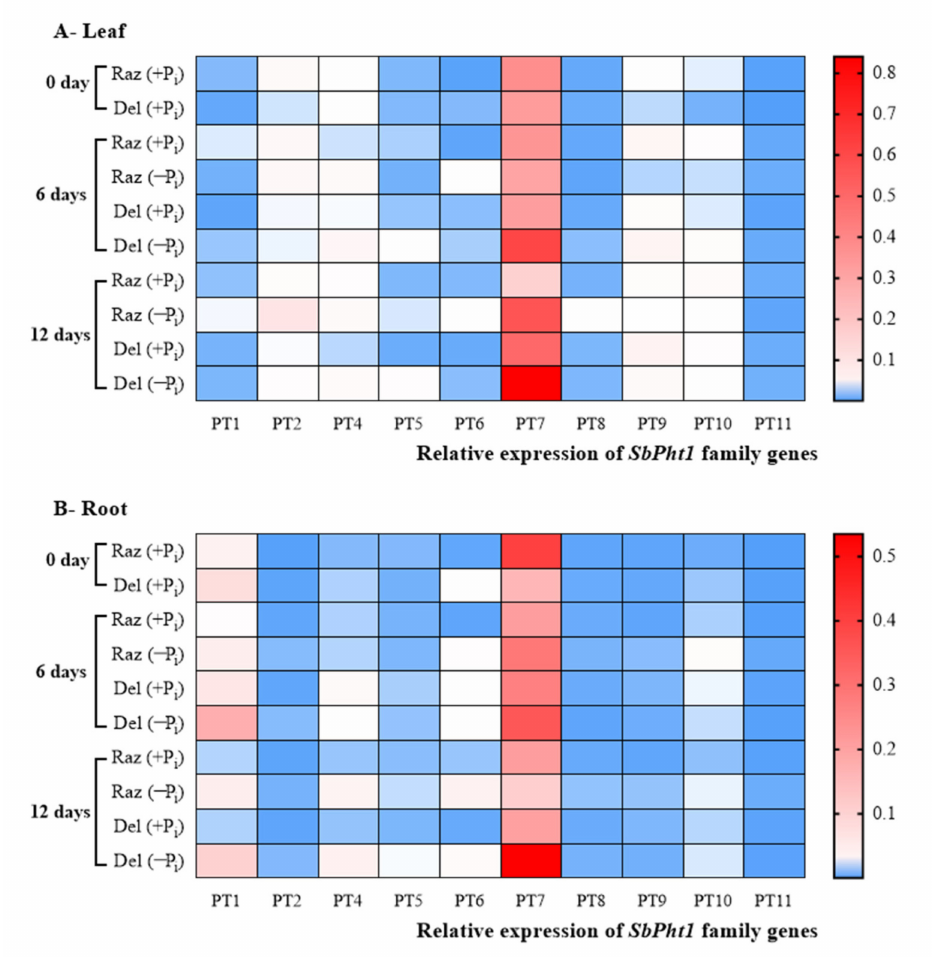
Figure 4. Expression profiles of 10 sorghum SbPht1 genes in leaves and roots of a grain (Razinieh) and a sweet (Della) sorghum variety grown under P i starvation treatments. ( A , B ) Relative expression of SbPht1 family genes in the leaf and the root, respectively. The seeds of two varieties were initially grown in agar with 8% MS for 10 days; after that, the seedlings were transferred to half Hoagland solution for 2 days, followed by full Hoagland solution for 4 days to obtain greater adaptation. Thereafter, the seedlings were subjected to 2 mM NH 4 H 2 PO 4 (normal condition; +P i ) or zero (phosphorous starvation; − P i ). After that, plant sampling for RNA extraction was conducted at 0, 6, and 12 days of P i starvation. Transcript levels were normalised against the ubiquitin housekeeping gene. Values are means of three biological replicates. Raz, Razinieh; d, day. The colour scale is shown on the right side. Heat map of gene expression profiles was generated using GraphPad Prism 8.4.3 software after data